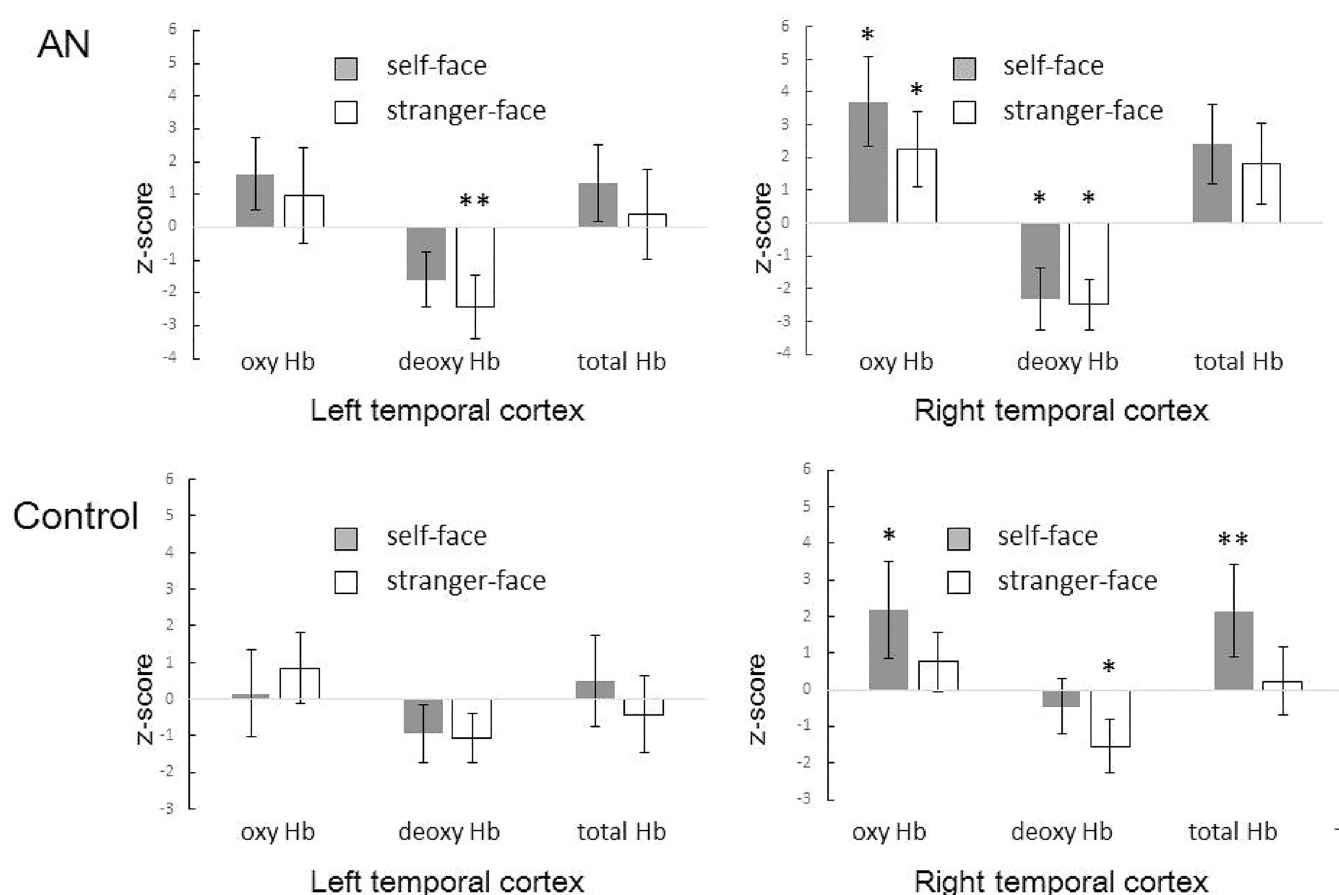
Fig 4. The mean Z-score during the 12 – 17 s period. The mean Z-score during the 12 – 17 s period after the onset of stimulation in the left and right temporal cortices. The gray bars represent the self-face condition and the white bars represent the stranger-face condition. The error bars represent one SD. The left and right panels indicate the data for the left and right temporal cortices, respectively; the top and bottom panels indicate the data from the AN and control groups, respectively. The statistical significance threshold was set to * P < 0.05.